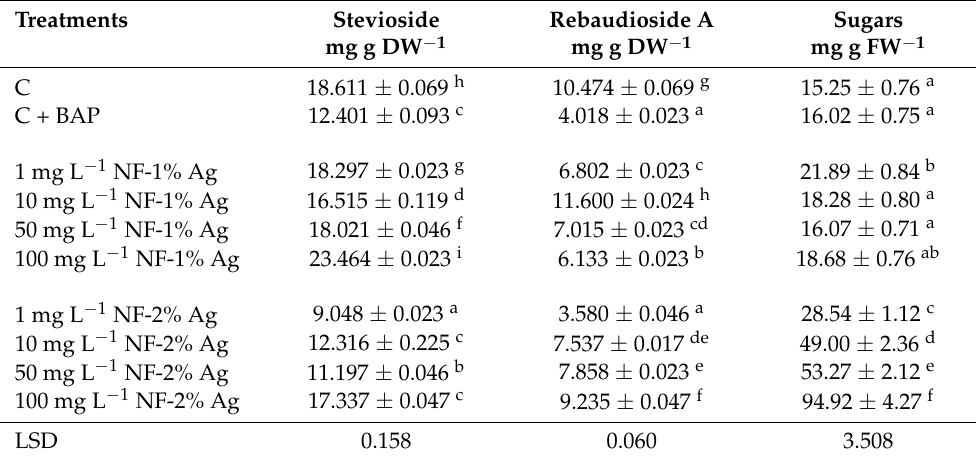
Table 2. Stevioside, rebaudioside A, and sugars contained in the Stevia rebaudiana plantlets in vitro propagated on MS medium free of BAP, on MS medium with BAP, and MS medium supplemented with various concentrations (1, 10, 50, 100 mg L − 1 ) of amino acid nanofibers enriched with 1% and 2% colloidal Ag (NF-1%Ag,